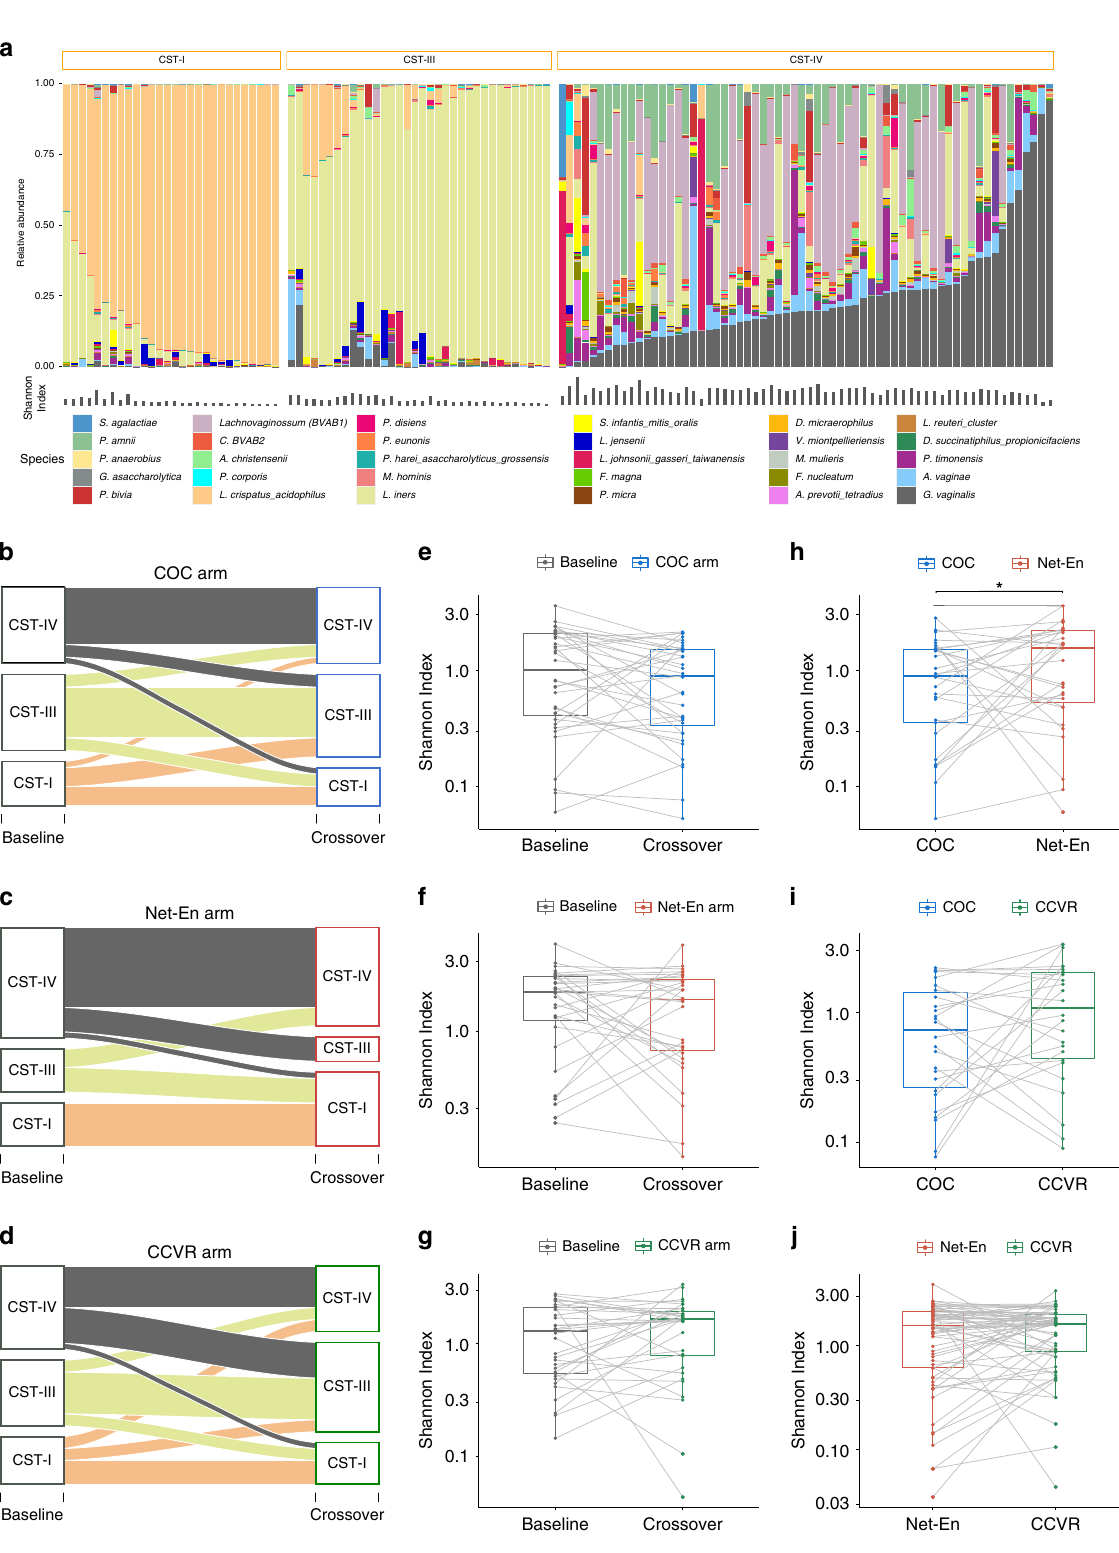
the three assigned study arms at crossover ( P = 0.026, R 2 = 0.040). Pairwise comparisons revealed that this difference was driven primarily by the differences between COC and Net-En ( P = 0.008, R 2 = 0.048) and to a lesser degree CCVR and COC ( P = 0.055, R 2 = 0.031), while there were no signi fi cant differ- ences between the Net-En and CCVR arm ( P = 0.383, R 2 = 0.012). After adjusting for baseline CST, the results from